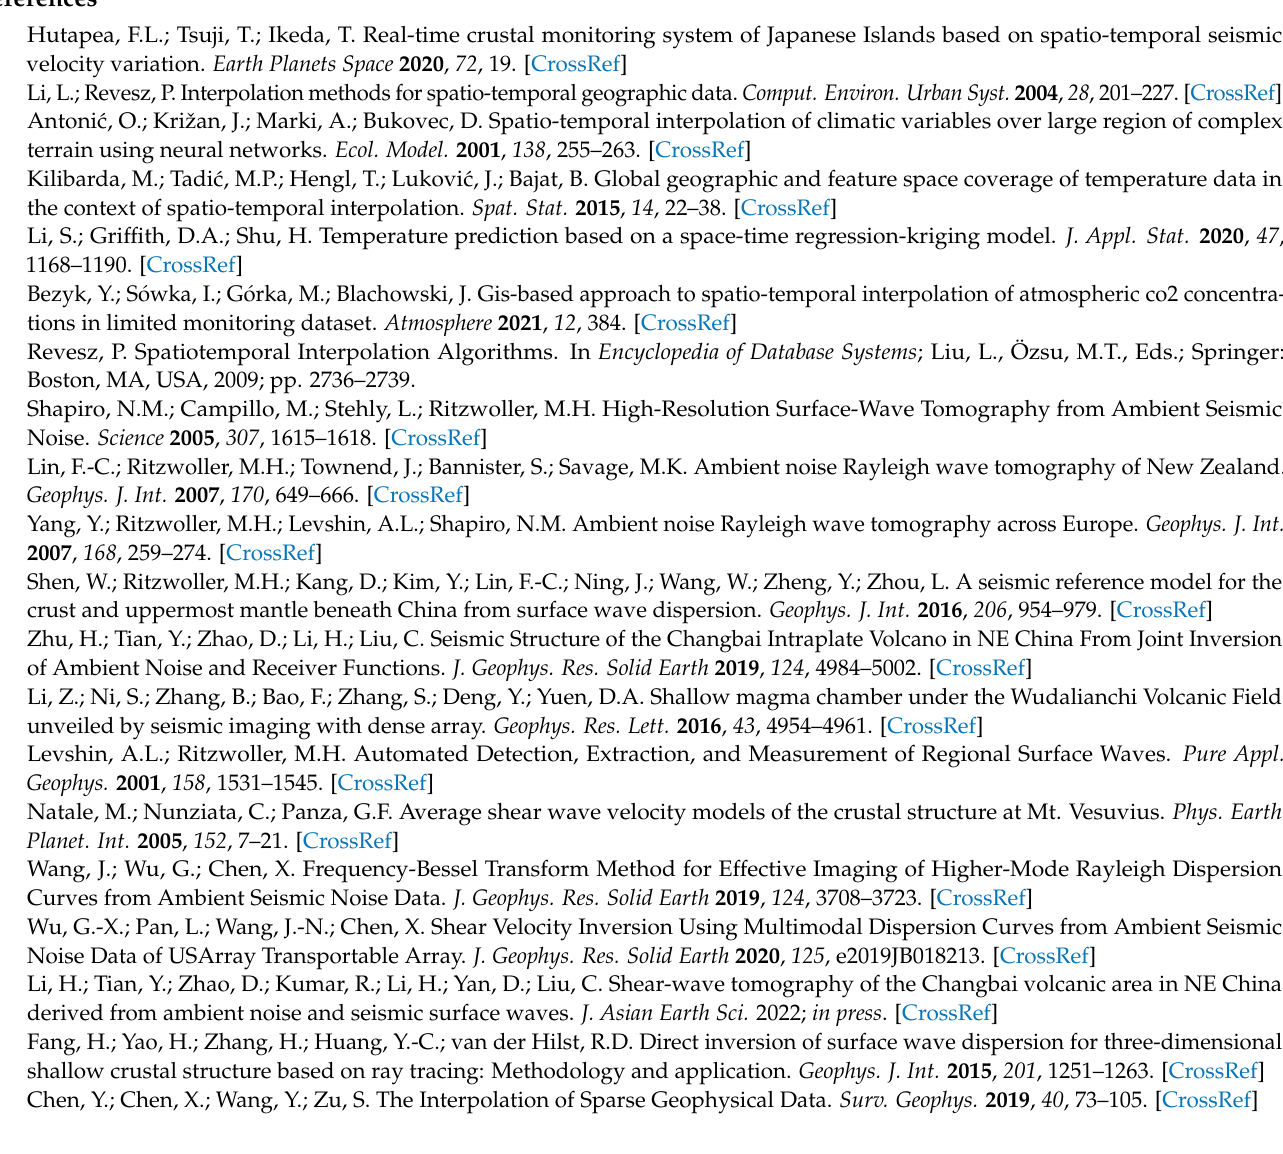
Figure A15. Original results imaged by 0.01° × 0.01° grid at different depths.